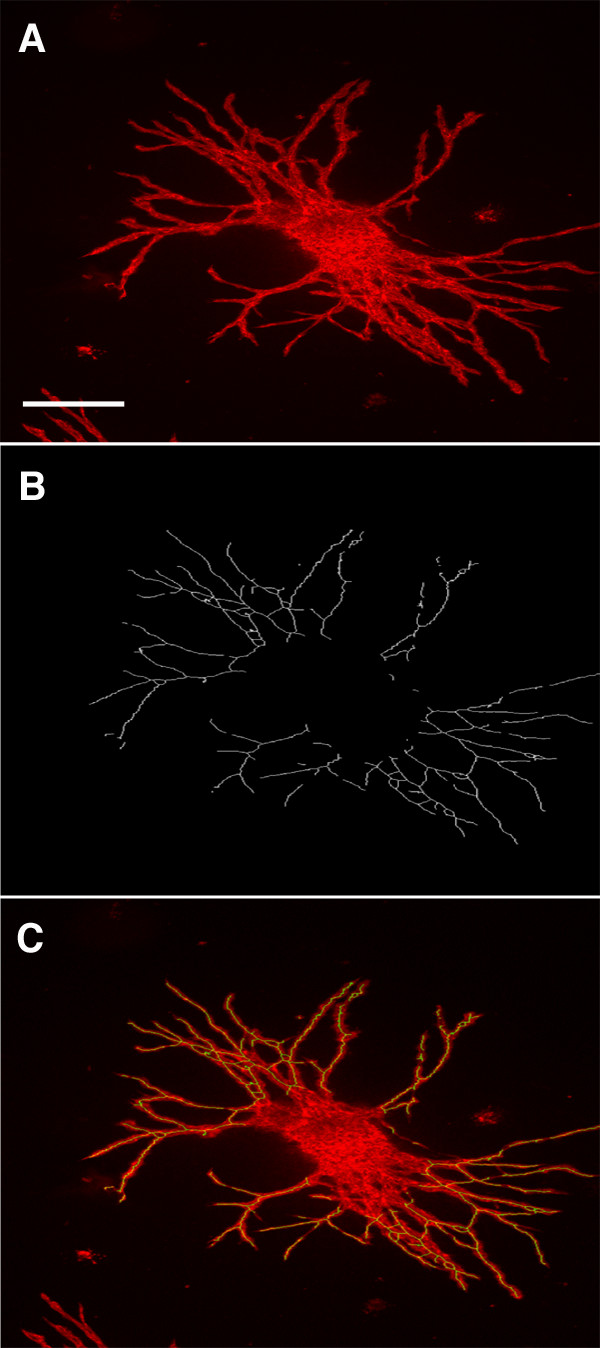
Image processing for quantitation of endothelial sprouting using MetaMorph Offline software. A, Initial image of the CD31 staining of an 11-day-old angiogenic EB derived from CJ7 ES cells; B, Skeletonized image of image A; C, Superposition of image B and image A. Scale bar = 400 μm.